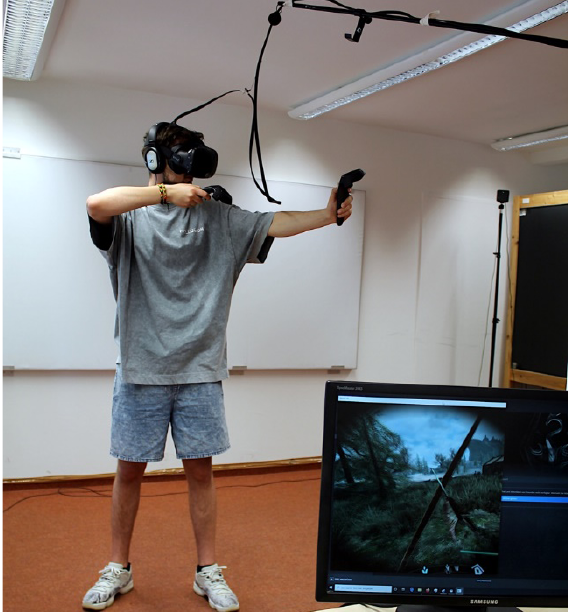
Figure 3. Laboratory setup of the VR gaming experimen- tal condition.